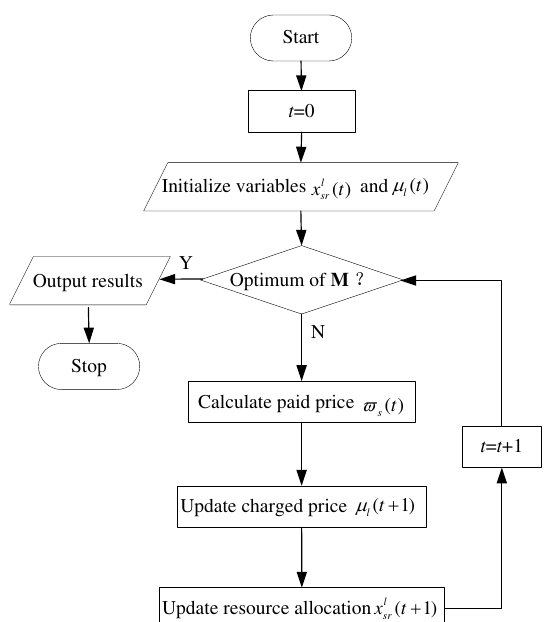
Figure 2. The flowchart of bandwidth allocation scheme for enterprise applications